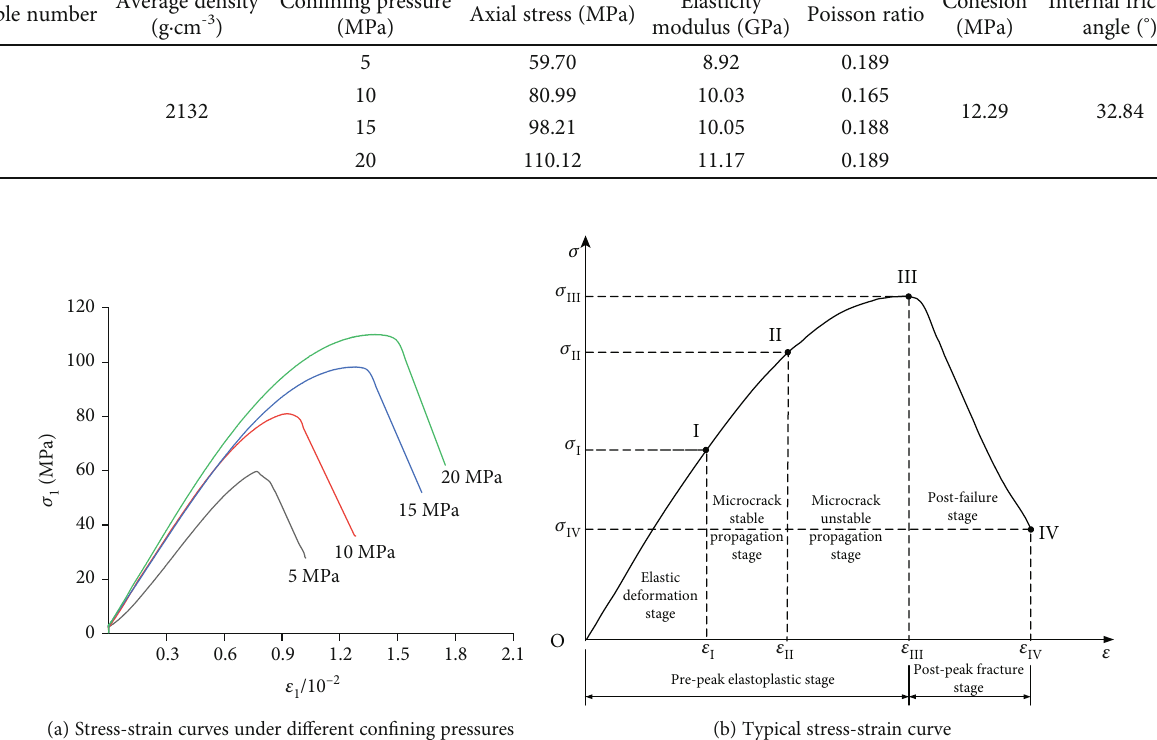
Figure 3: Stress-strain curves of red sandstone under di ff erent con fi ning